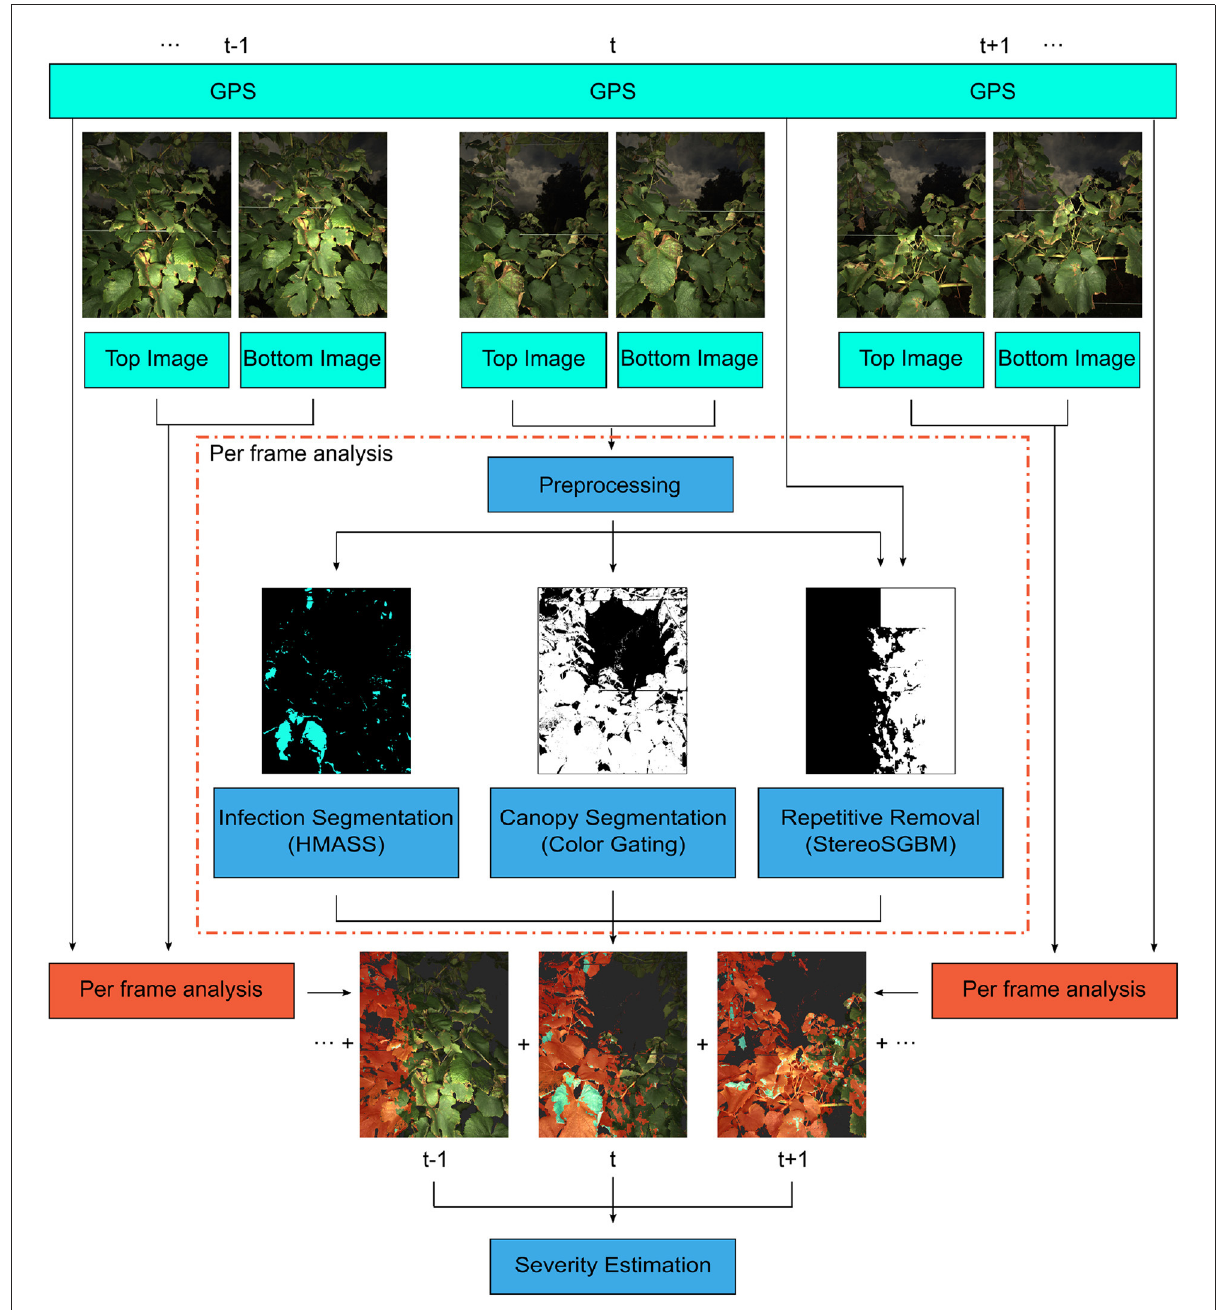
FIGURE2 The processing pipeline for disease severity quantification. For each frame, the stereo image pair and GPS location were used to generate pixel-level disease classifications (masks). These masks were combined to provide panel severity rates. Hierarchical Multi-scale Attention for Semantic Segmentation (HMASS) network is a deep convolutional neural network for semantic segmentation.